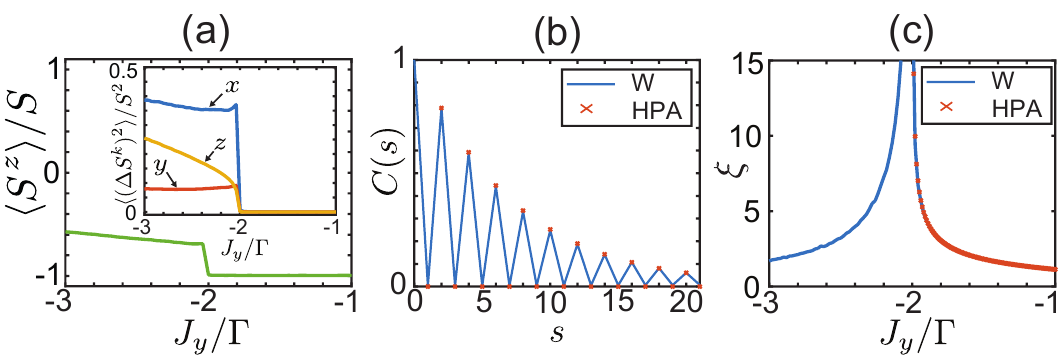
Figure 7: Stochastic simulation of the steady state of a dissipative Heisenberg chain as described by Eq. (35). (a) Magnetization 〈 S z 〉 and variances 〈 ( ∆ S x , y , z ) 2 〉 as a / Γ for a fixed value of J = Γ / 2. (b) Plot of the spin-spin correla- function of J y x 〉 / 〈 S + 〉 for a value of J / Γ = − 1.96 near the phase transition S − S − tions C ( s ) = 〈 S + y n n + s n n point. (c) Plot of the correlation length ξ extracted from a fit of C ( s ) = e −| s | /ξ (for s even) as a function of J . In all plots the solid line represent the results obtained y using the TWOQS and the crosses show the analytic predictions obtain from the Holstein-Primakoff approximation in the polarized phase. For the stochastic simula- tions we have assumed a chain of N = 100 sites with periodic boundary conditions and S =